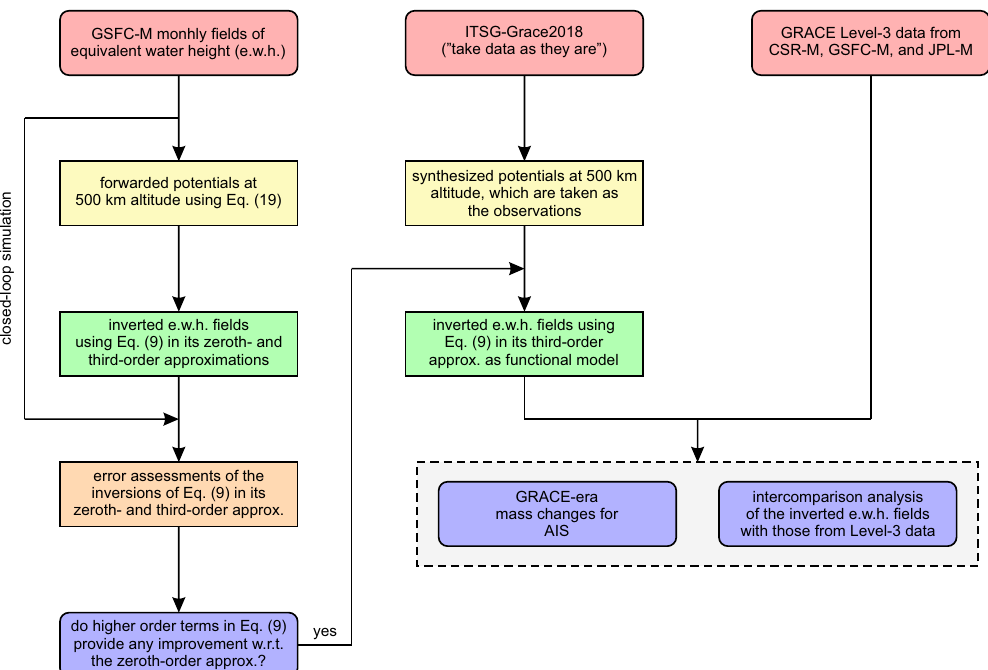
Figure 1. Flow chart showing the experiment used for assessing the original (zeroth-order) and improved point-mass (third-order) solutions as per Equation (10) as well as a study case over Antarctica using GRACE Level-2 data as given by ITSG-Grace2018.